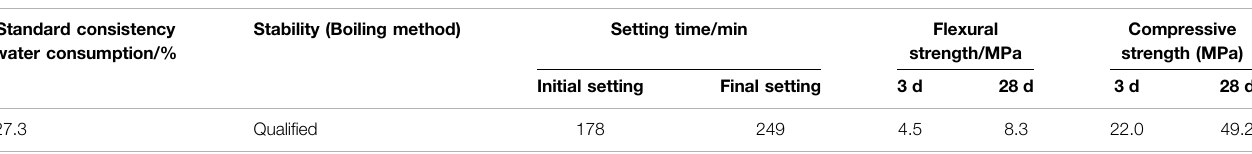
TABLE 2 | Cement performance